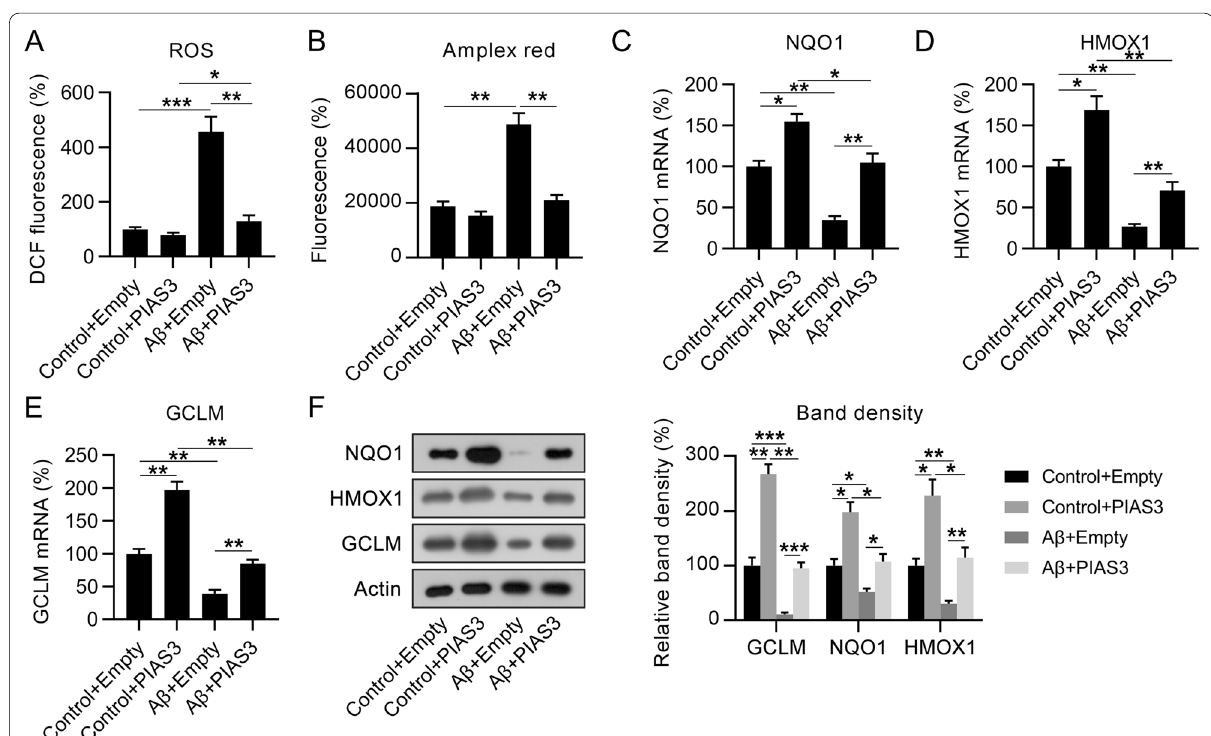
Fig. 4 Effects of PIAS3 overexpression on oxidative stress in Aβ-treated SH-SY5Y cells. Cells were subjected to transfection with a PIAS3 overexpression vector or an empty vector for 2 d, and subsequently subjected to Aβ treatment (20 μM in 0.1% DMSO) for an additional 1.5 d. A , B ROS generation was determined by DCF-fluorescence and Amplex red stain at 24 h post transfection. C – F qPCR and WB were performed for determining the levels of NQO1, HMOX1, and GCLM in SH-SY5Y cells. Data represent mean SEM. *p < 0.05, **p < 0.01, ***p < 0.001. PIAS3 protein ± inhibitor of activated STAT3, qPCR quantitative polymerase chain reaction, Aβ amyloid beta, WB western blotting, ROS reactive oxygen